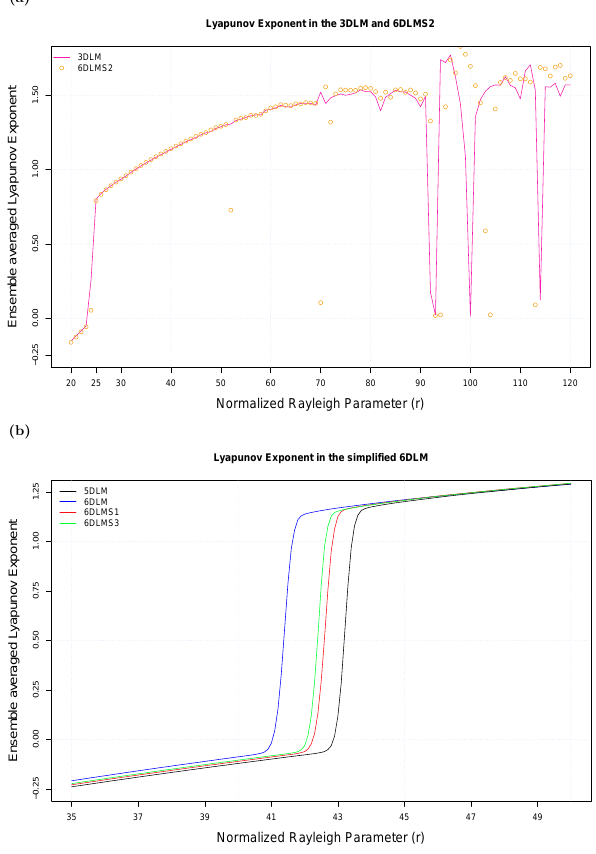
Figure 5. Same as Fig. 4 except for (a) the 3DLM (in pink) and the 6DLMS2 (in orange), and (b) the 6DLMS1 (in red) and 6DLMS3 (in